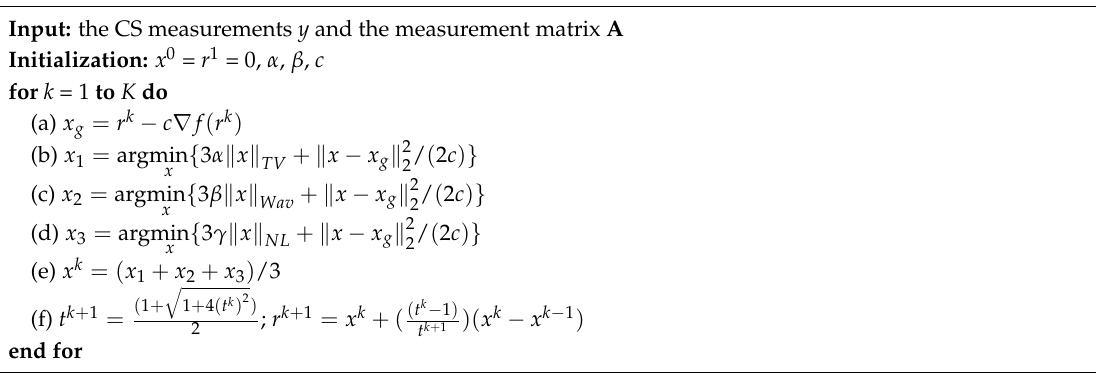
Algorithm 3. CS with Plug-and-play